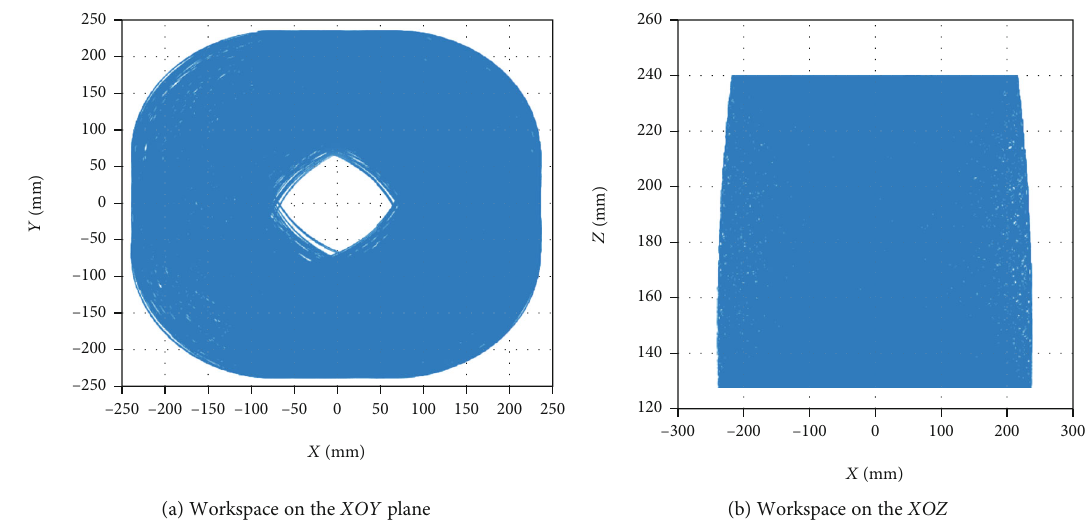
Figure 10: The projection of the MRI-compatible breast interventional robot workspace on the XOY plane and XOZ